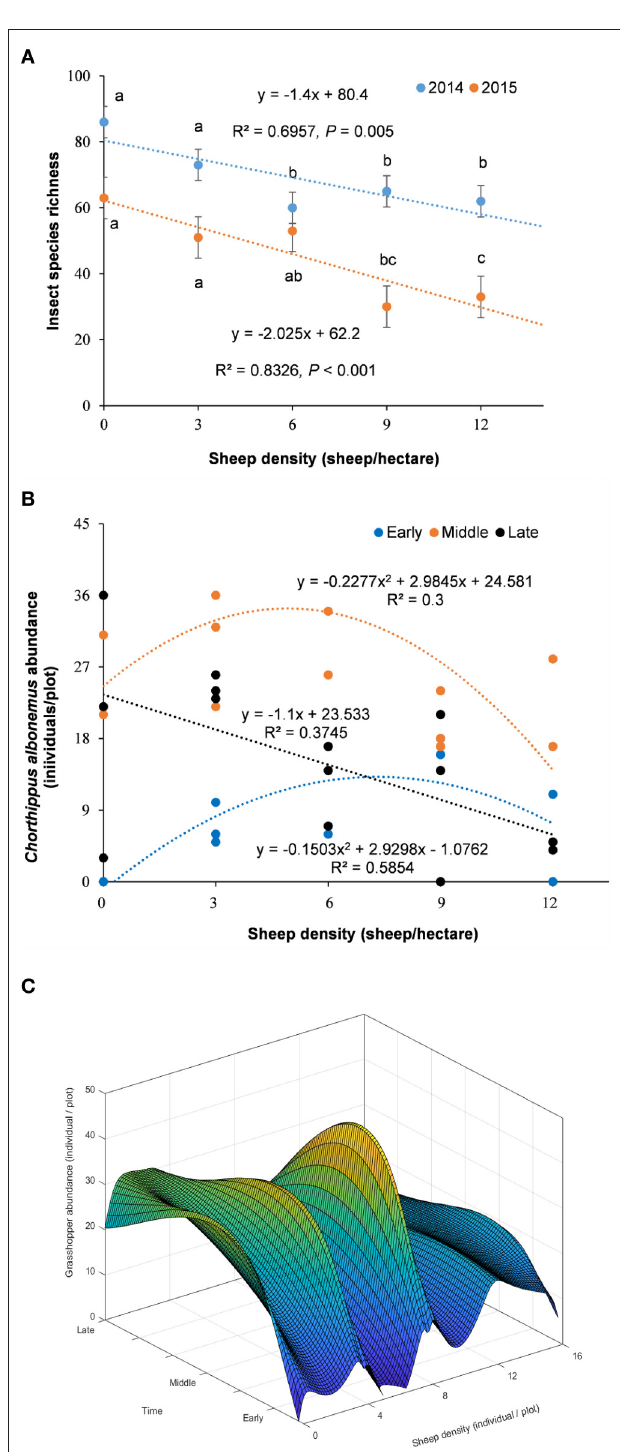
FIGURE 2 | (A) Variation in total insect species richness across a grazing intensity gradient. Results are expressed as mean ± SE. The comparisons with different letters are for within-year at the significance of P < 0.05. (B) Chorthippus albonemus abundance under different grazing intensities. (C) Temporal dependent disturbance-abundance relationship. Early, early July; Middle, late July; Late, middle August.